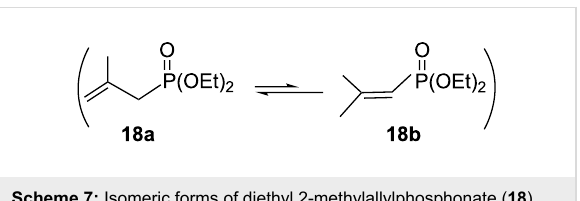
Scheme 7: Isomeric forms of diethyl 2-methylallylphosphonate ( 18